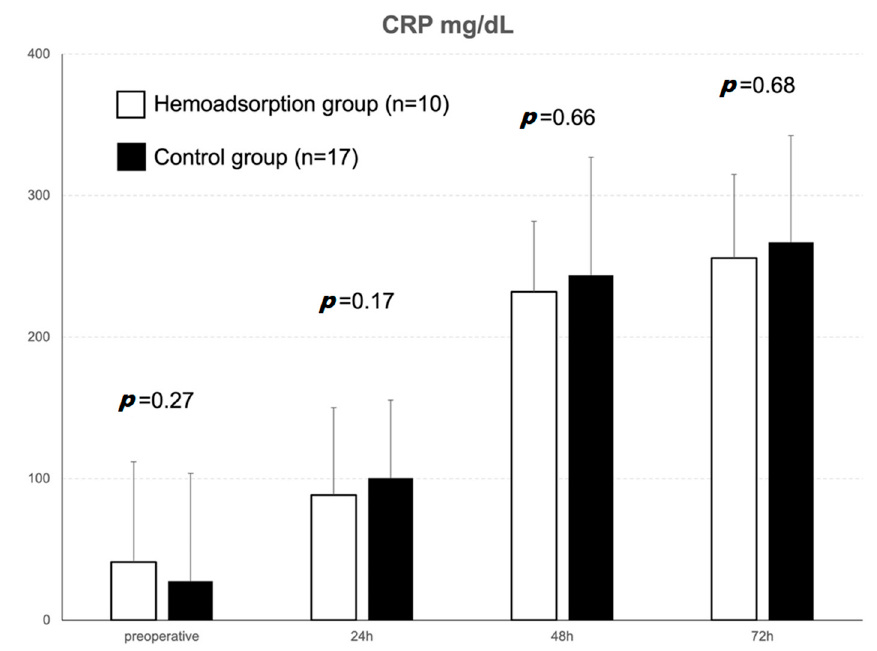
Figure 2. Course of CRP levels up to 72 h postoperatively (mg/dL). The operative characteristics and post-operative outcome results are presented in